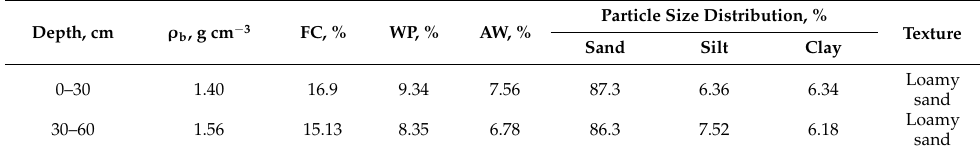
Table 2. Mechanical analysis and some soil physical